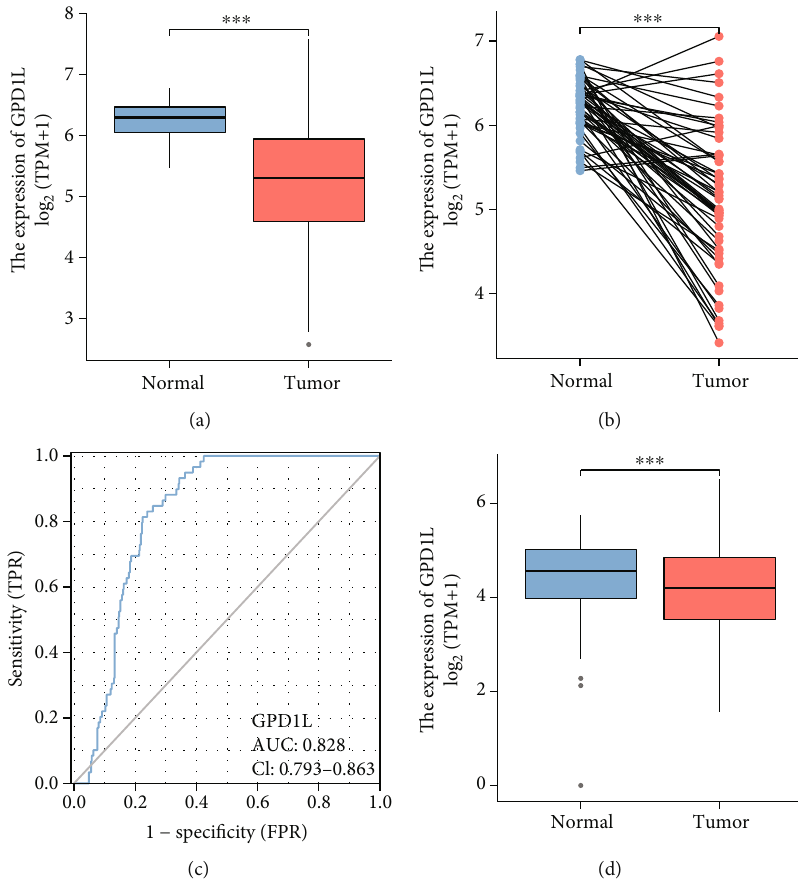
Figure 2: The levels of GPD1L expression in LUAD, as well as the diagnostic usefulness of this protein. (a, b) The levels of GPD1L expression found in LUAD specimens as compared to those found in nontumor tissues. (c) The ROC tests were utilized to evaluate the diagnostic potential of GPD1L. (d) The levels of GPD1L expression found in LUAD specimens compared to those found in non-tumor specimens, as determined by the TCGA or GTEx database. ∗ p < 0 : 05 , ∗∗ p < 0 : 01 , ∗∗∗ p < 0 : 001 ; ns: no signi fi